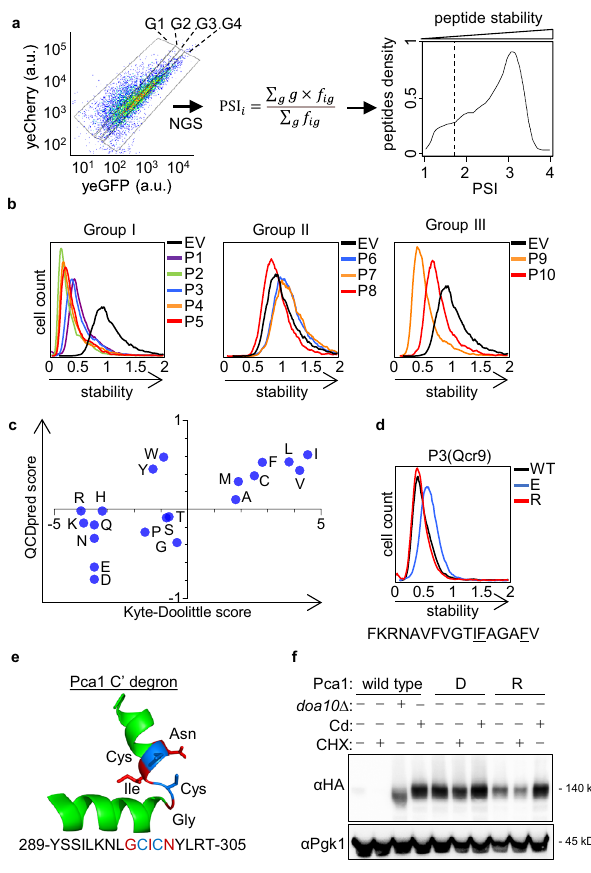
Fig. 2 | QCAP degrons functionality is largely de fi ned by their amino acid composition.a Fluorescence-activatedcellsortingofyGPS-P lib intofourgates(G1- 4), each composed of 2.5 million cells, was followed by NGS and protein stability index (PSI) scoring of each peptide, leading to the formation of a peptide density map. Shown is a FACS illustration and gating of 10,000 cells. Degron cutoff at PSI<1.7 is marked by a dashed line. a.u.: arbitrary units. b Validation of QCDPred- baseddegronpredictions.TenDNAfragmentsfromthelibrarywerere-clonedinto yGPS-P, followed by fl ow cytometry analysis. The corresponding peptides were dividedintothreedifferentgroups:GroupI-PSI ≤ 1.62, P ≥ 0.85;GroupII-PSI>1.62, P <0.85; Group III- PSI ≤ 1.62, P <0.85. Stability scale: Median value of the yeG/yeC ratio in empty vector (EV) control was set as one. All other histograms were dis- tributed accordingly. c Scatter plot comparing Kyte-Doolittle hydrophobicity aminoacidscoresandQCDPredprobabilities. d Flowcytometryhistogramofintact and mutant P3 peptide in which three amino acids were replaced with either glu- tamate (E) or arginine (R) residues. Stability scale was set as shown in Fig. 2B. e 3D structure of QCDPred-calculated cytosolic Pca1 degron (amino acids 289-305), based on AlphaFold Pca1 structural model #AF-p38360-F1 (Conf. (90>pLDDT > 70).Markedbyabluecolorarethecysteineresidues.Markedbyaredcolorarethe three amino acids that have been replaced with aspartate or arginine. pLDDT: per- residuecon fi dencescoreonascaleof0-100. f ImmunoblotanalysisofPca1protein levels. Wild type or doa10 Δ ( d Δ ) cells, expressing the indicated HA-tagged Pca1 proteins were left intact or treated with 50 μ M CdCl 2 for 1h. To determine degra- dation, where indicated, the translation inhibitor cycloheximide (CHX) was added to cells for 15min before cell harvesting. Pca1 levels were measured by immuno- blotting using anti-HA Abs while Pgk1 levels served as a loading control. This ana- lysis wasrepeatedtwo times. D: replacementofresiduesmarked in2Eby redcolor withaspartate;R:replacementofresiduesmarkedin2EbyredcolorwithArginine. Source data for panels a-d and f are provided as a Source Data fi